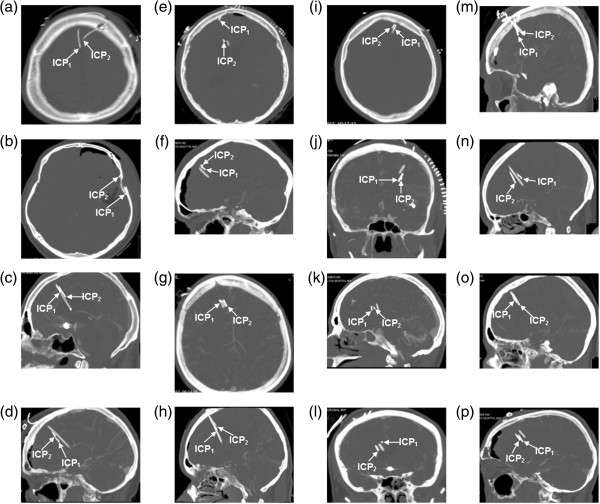
Locations of ICP sensors 1 and 2 on cerebral computer tomography (CT). The CT scans showing the two ICP sensors (ICP1/ICP2) in (a) Patient 1, (b) Patient 2, (c) Patient 3, (d) Patient 4, (e) Patient 5, (f) Patient 6, (g) Patient 7, (h) Patient 8, (i) Patient 9, (j) Patient 10, (k) Patient 11, (l) Patient 12, (m) Patient 13, (n) Patient 14, (o) Patient 15, and (p) Patient 16.